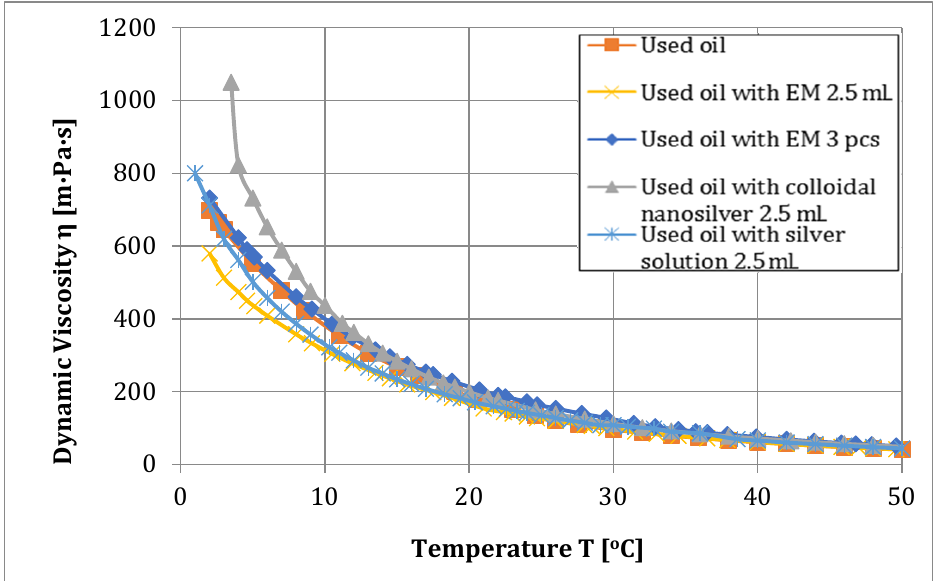
Figure 11. Comparison of viscosity of samples of used oil with and without the addition of effective microorganisms (EM), colloidal nanosilver (CN), and silver solution (SS).